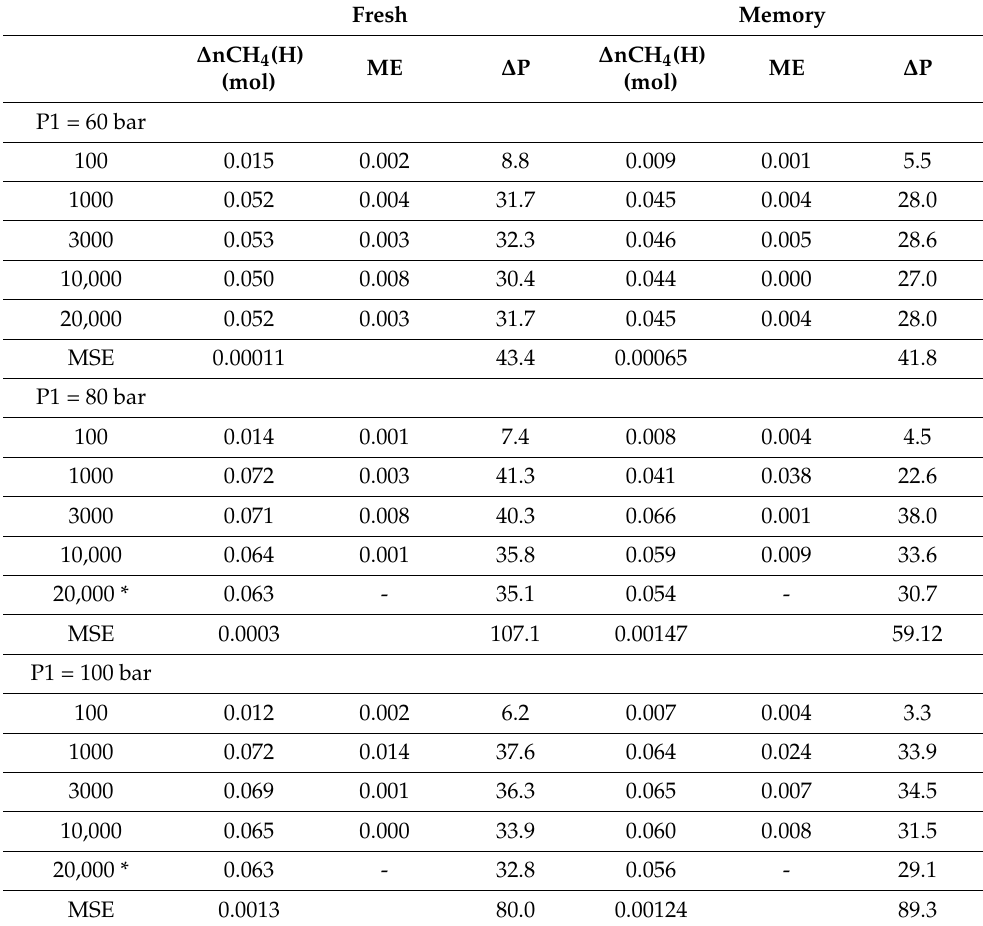
Table A7. Total gas uptake in hydrates and pressure drop during the fresh and memory run in the presence of L-methionine at five different concentrations. T = 1 ◦ C, Peq = 28.68 bar (nCH 4 (H) = total moles of CH 4 stored in hydrates, ∆ P = total pressure drop) * Single experiment details available only. ME = margin of